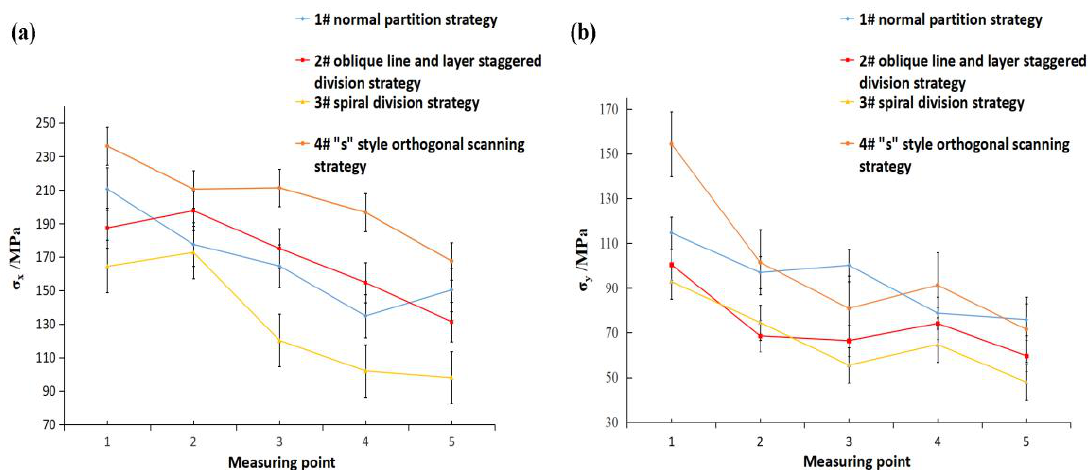
Figure 10. Distribution of residual stress: ( a ) X-direction residual stress distribution curve; ( b ) Y-direction residual stress distribution curve.